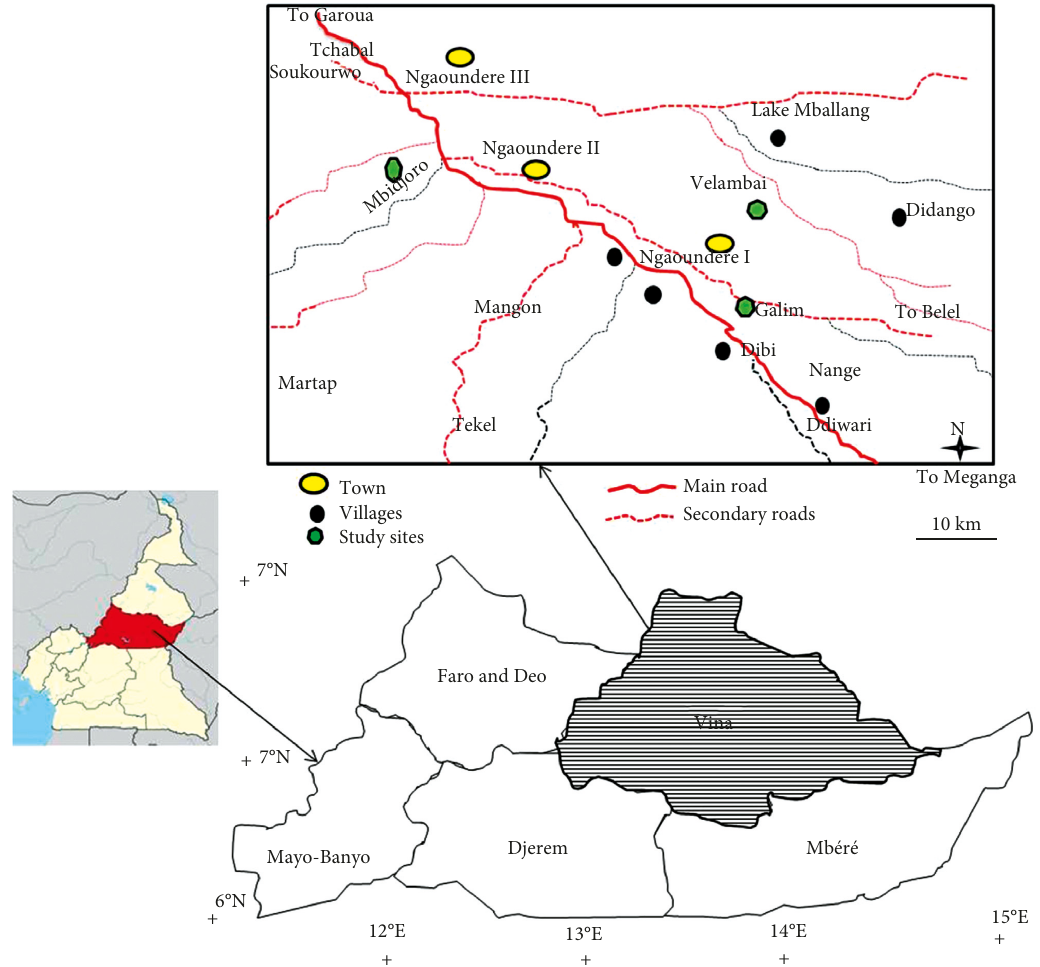
Figure 1: Map of the study area indicating the study sites. Table 1: ADT of Stomoxys spp. with respect to prospected sites. Stomoxys spp.